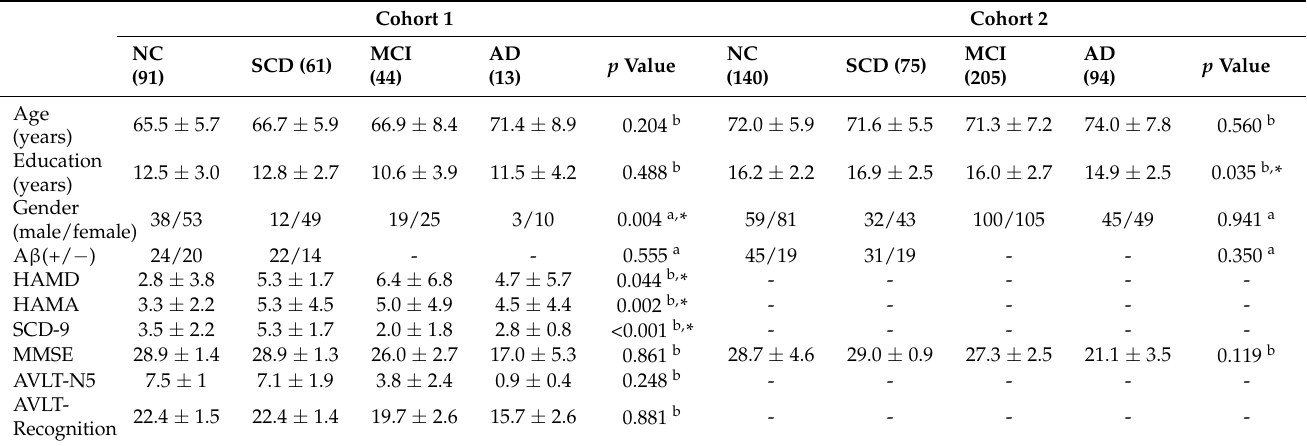
Table 1. Demographic characteristics.